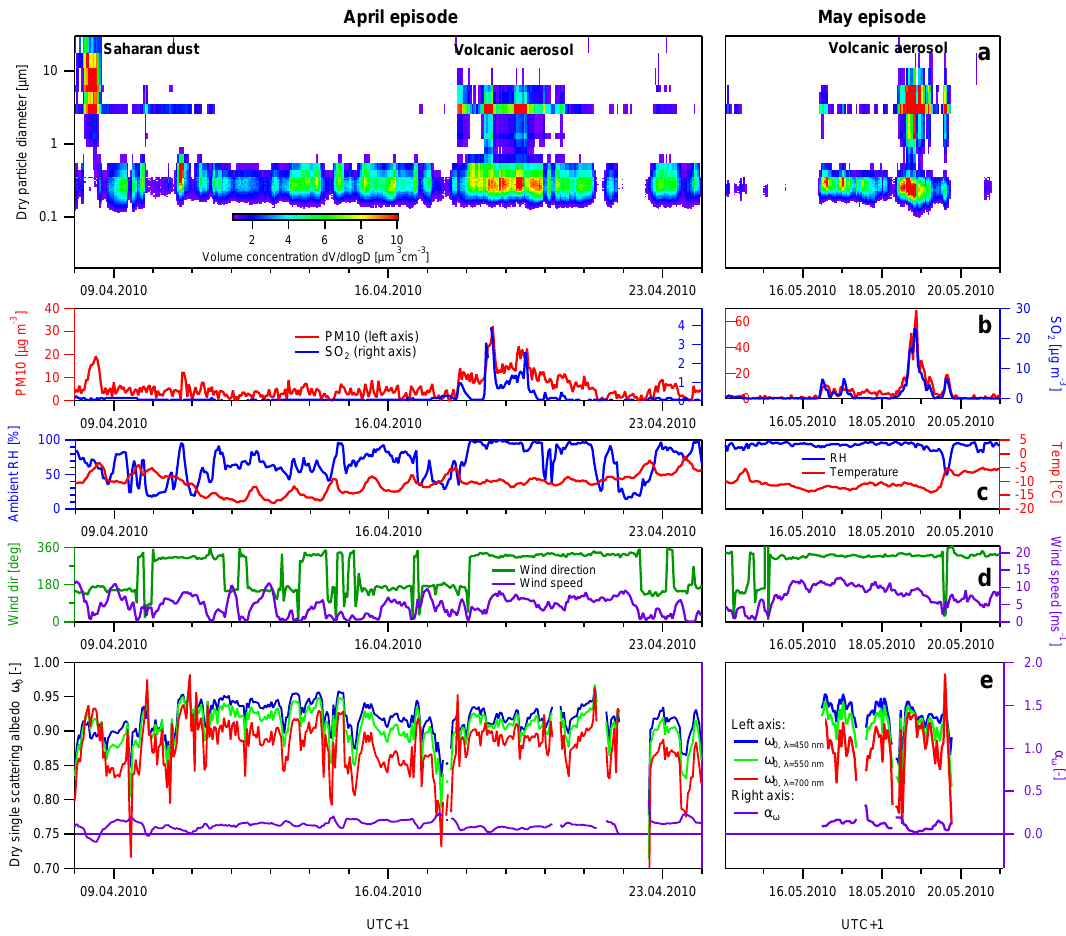
Fig. 1. Temporal evolution of aerosol, gas phase and meteorological parameters measured at the Jungfraujoch around the volcanic aerosol plume and Saharan dust episodes in April 2010 (left panels) and May 2010 (right panels). ω 0 : dry single scattering albedo (laboratory conditions). α ω : ˚Angstr¨om exponent of the dry single scattering albedo. Time is local time